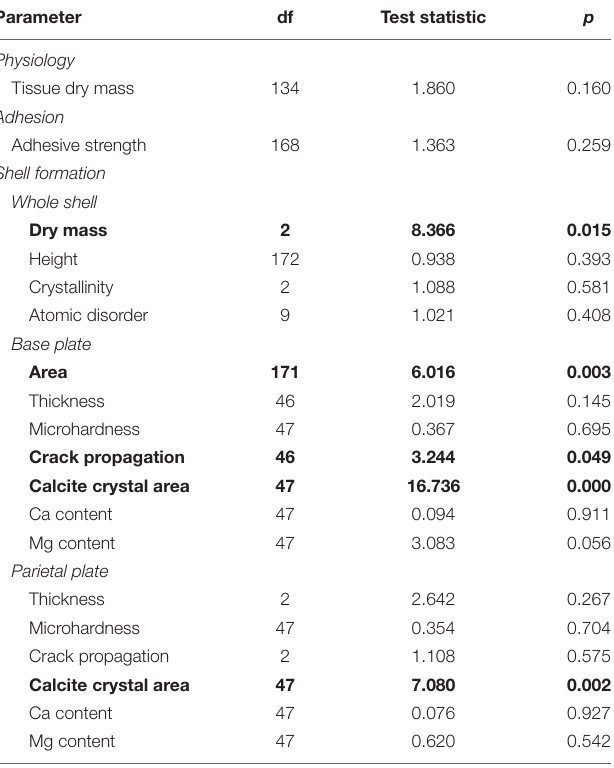
TABLE 2 | Assessment of the effects of seawater pH on physiology, adhesion, and shell formation in the barnacle Amphibalanus amphitrite .